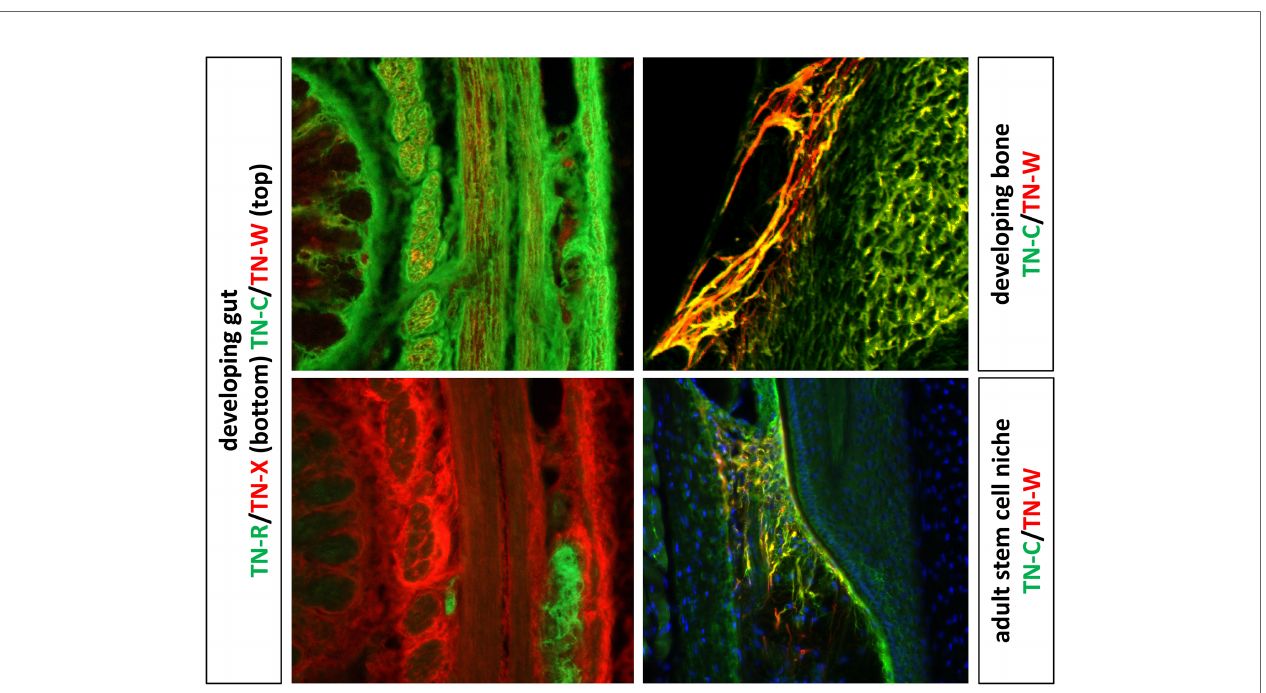
FIGURE 2 | The images to the left show double label immunohistochemistry of the developing gut with antibodies to TN-C, TN-W, TN-R and TN-X. TN-C expression is widespread, while TN-W is found in small patches in a subset of the smooth muscle. TN-R is limited to the autonomic ganglia of the gut, while TN-X is concentrated in the epimysium surrounding bundles of smooth muscle. On the top right is a section of a developing ulna immunostained with antibodies to TN-C and TN-W. Both are strongly expressed in developing bone, with partially overlapping patterns (yellow). On the bottom right is a section though the whisker follicle stem cell niche of an adult mouse. The patterns of TN-C and TN-W expression are more limited in the adult, but they are found in partly overlapping patterns in this stem cell niche. Original images of the developing gut and bone from Meloty-Kapella et al. (40) and adult stem cell niches from Tucker et al. (41) with